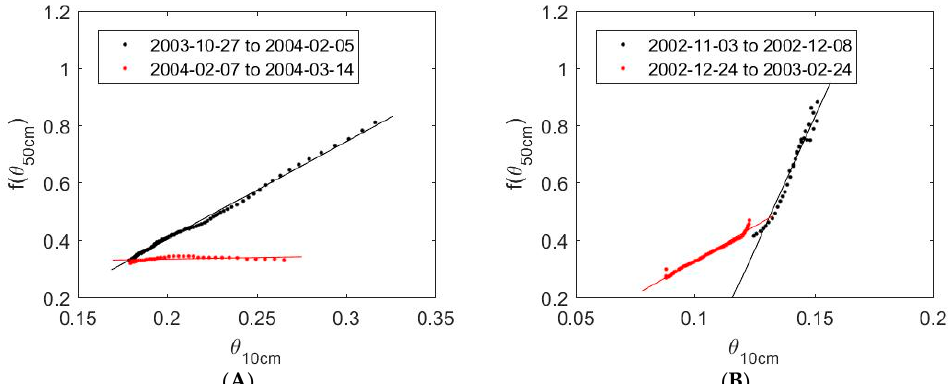
Figure 2. Time series of soil moisture stress index (SMSI) and f ( θ root ) at ( A ) MKL site and ( B ) SKR site. Soil moisture at 10 cm ( θ 10cm ) and 50 cm ( θ 50cm ) depths are also shown.